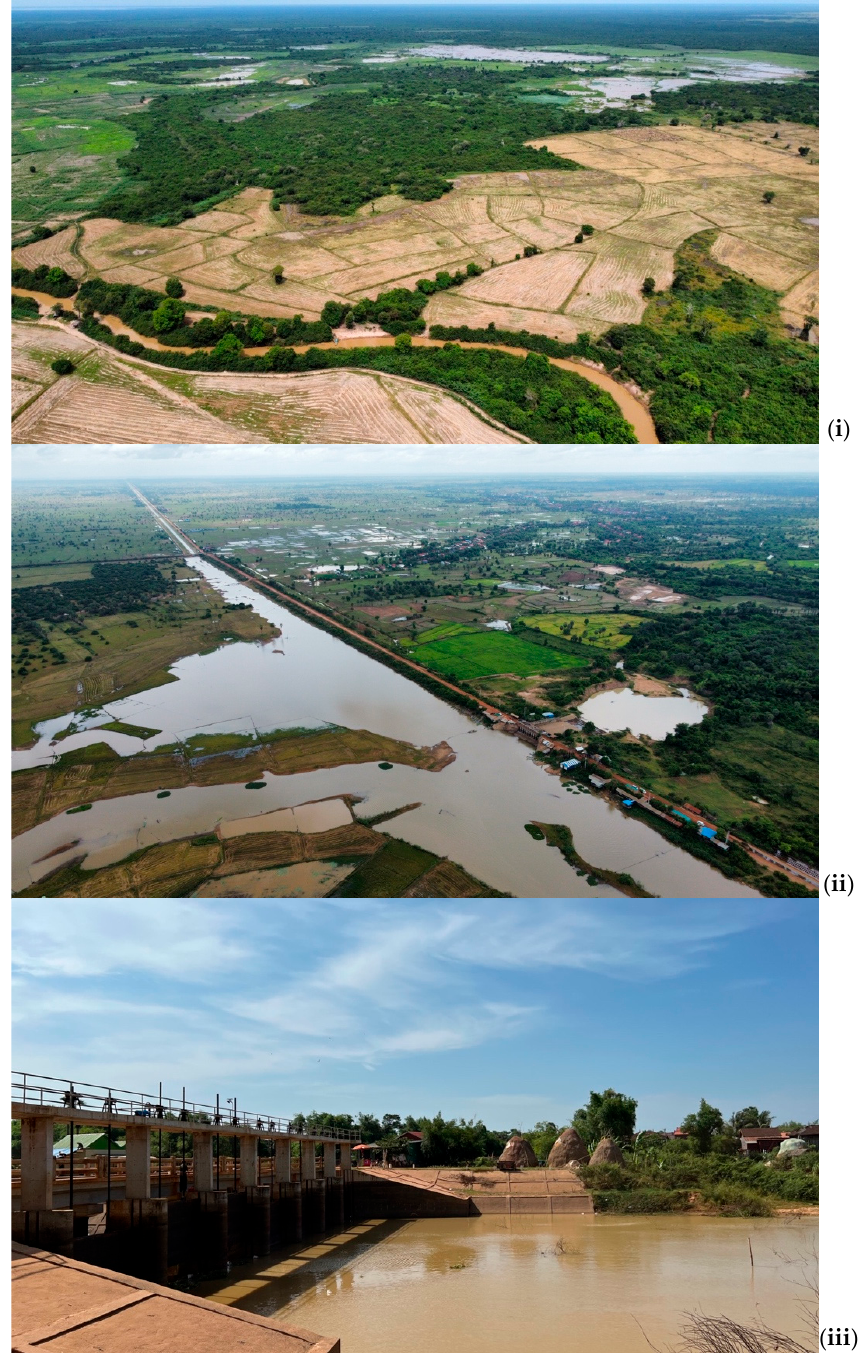
Figure 13. Land conversion and irrigation projects in the Stung Staung River . Major projects impact Boeng Chhmar’s hydro − ecological condition, inhabited forest and local livelihoods: ( i ) land conversion of forest to rice field and reforestation; ( ii ) part of the Asian Development Bank’s (ABD) irrigation upgrading project; and ( iii ) a flood gate and canalized river project in Pralay commune (Linh Vu, April 2022).